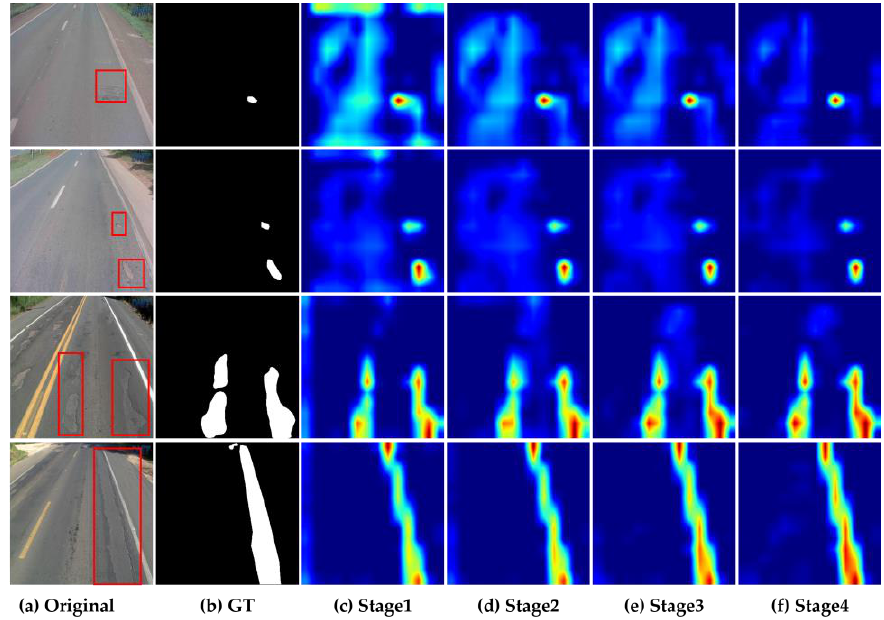
Figure 11. Attention map visualization of multiscale potholes in the CPRID. Blue indicates a lower attention value, and red indicates a higher attention value. There is a red outline around the pits in the original image.